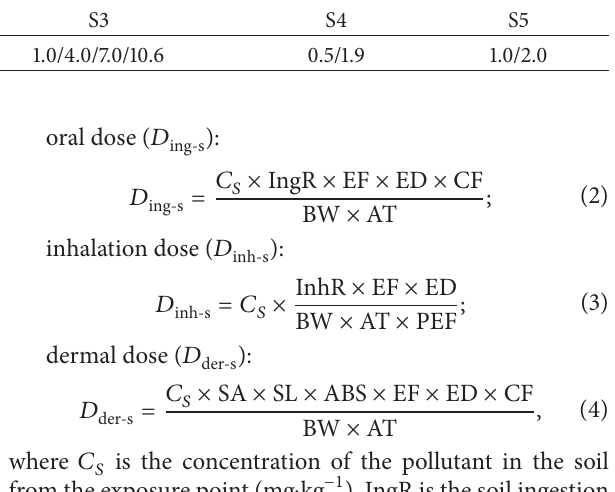
Table 1: Soil sampling depths at the abandoned open dumpsite. Points from boundary area of the